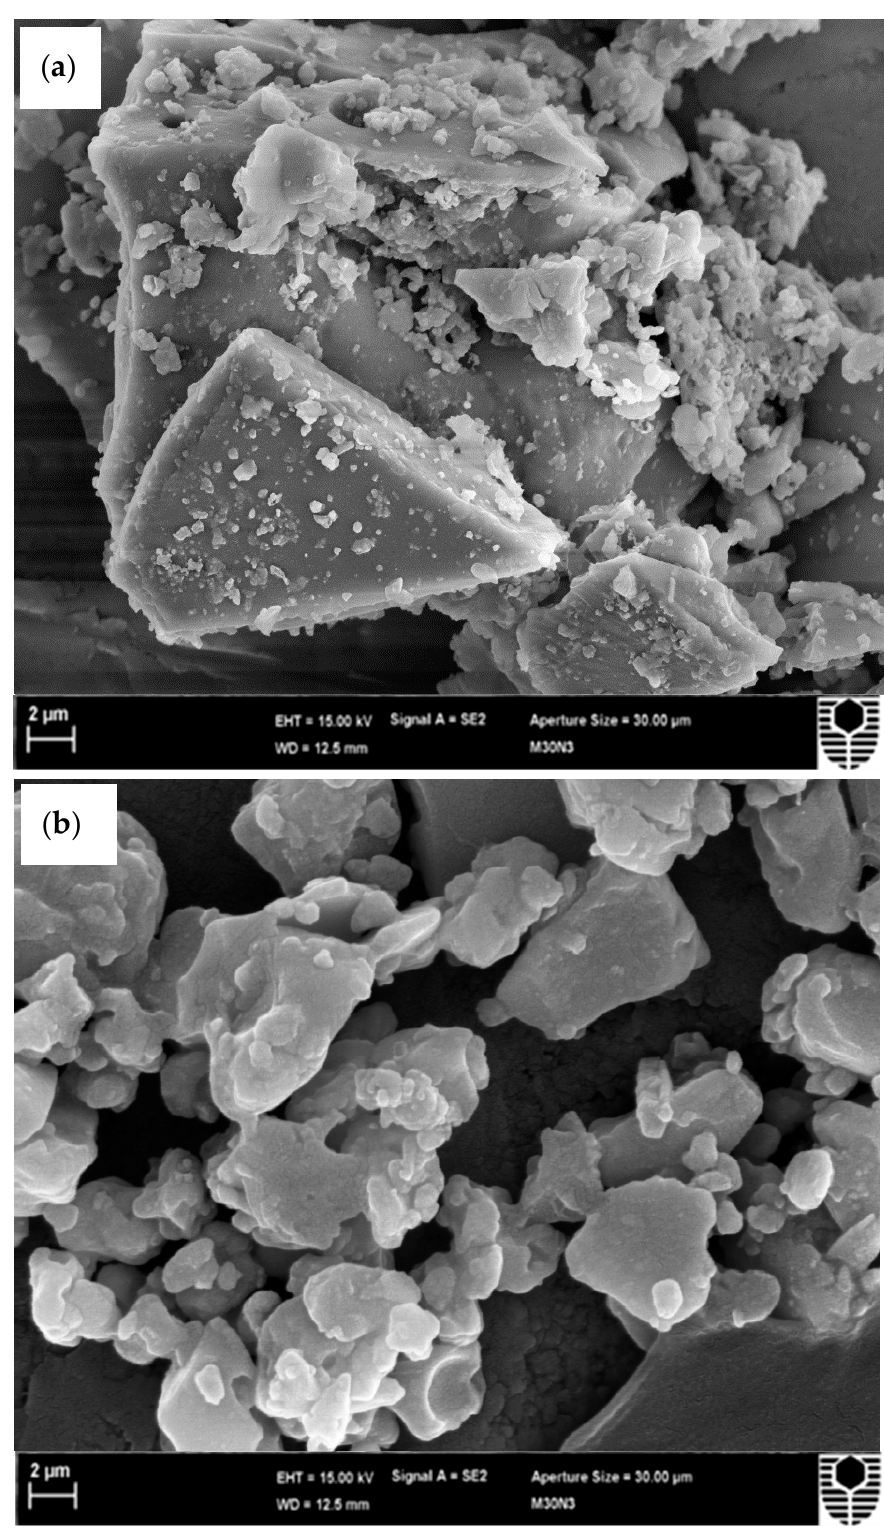
Figure 5. Surface morphology of micro ( a ) and nano ( b ) POFA.